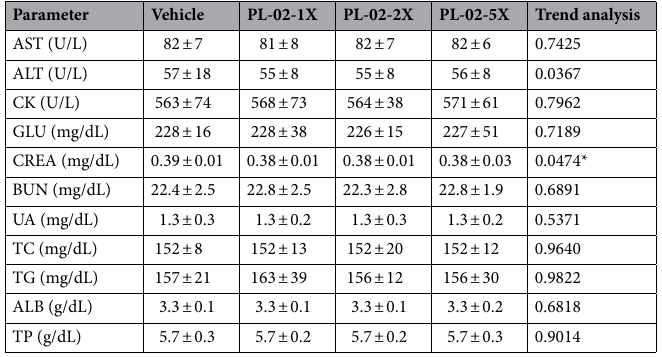
Table 3. Effects of PL-02 on biochemical parameters. Data are expressed as mean ± SD (n = 10 mice per group). AST, aspartate aminotransferase; ALT, alanine transaminase; CK, creatine kinase; GLU, glucose; CREA, creatinine; BUN, blood urea nitrogen; UA, uric acid; TC, total cholesterol; TG, triacylglycerol; ALB, albumin; TP, total